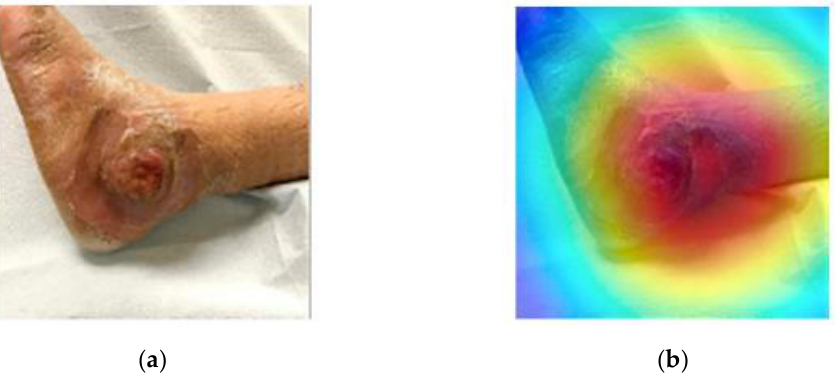
Figure 4. Chronic wound image and its importance map using LIME [30]: ( a ) original wound image; ( b ) importance map.